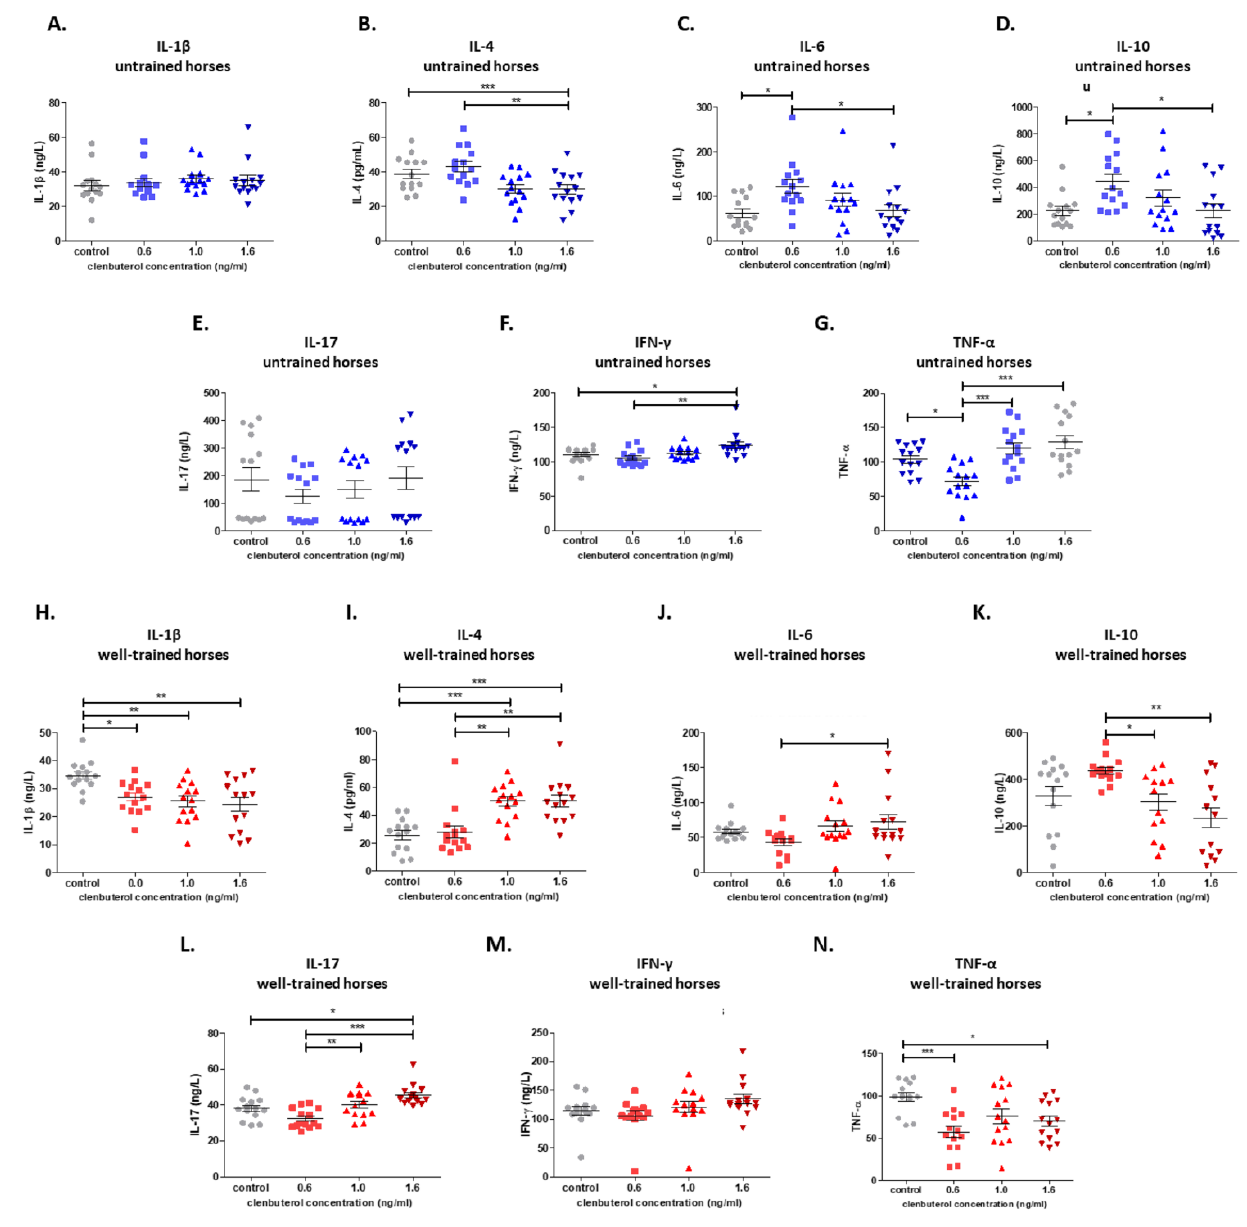
Figure 5. Graphic representation showing the cytokine concentrations: IL-1β ( A , H ), IL-4 ( B , I ), IL-6 ( C , J ), IL-10 ( D , K ), IL-17 ( E , L ), TNF-α ( F , M ), and IFN-γ ( G , N ) presented in the culture medium of control and clenbuterol-treated PBMCs obtained from untrained and well-trained horses. Each dot represents one individual horse ( n = 28) and means ± SEM (standard error of the mean) are presented. The significance levels are: * p < 0.05; ** p < 0.01, and *** p < 0.001.